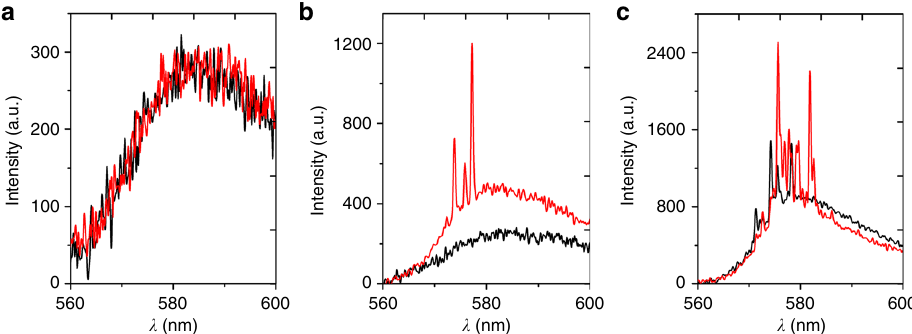
Fig. 4 Soliton switching of random laser. Emission spectra gated over 100 ms, obtained without (black lines) and with a co-launched 6 mW nematicon (red lines) when the pump energy per pulse (in the absence of near-infrared input) is a below threshold ( E = 0.45 μ J), b almost at ( E = 0.48 μ J), c above threshold ( E = 0.55 μ J)